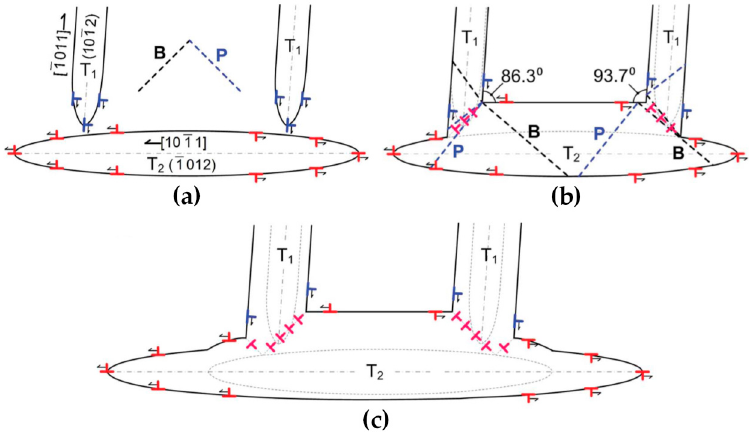
Figure 29. Schematic illustrations of a twin–twin intersection. ( a ) Before impingement; ( b ) Formation of a twin–twin intersection; ( c ) Twin growth after the twin–twin intersection. (Reprinted from Reference [153], with permission from Taylor & Francis).